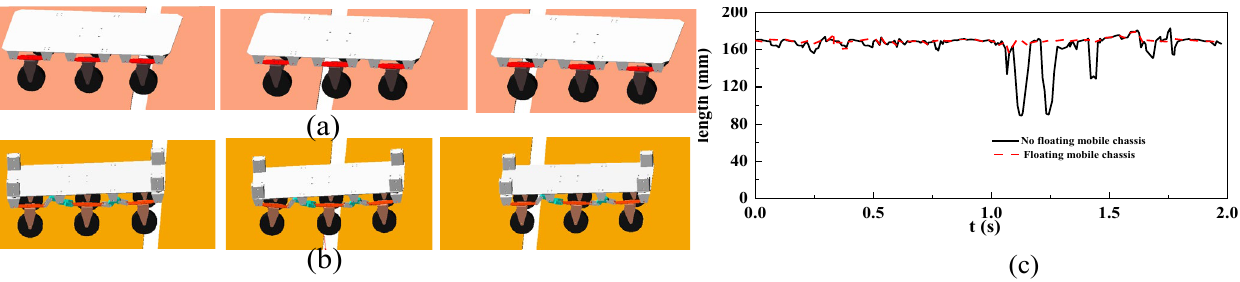
Figure 10. Motion simulation of boss crossing obstacles: ( a ) the obstacle-climbing process of no float- ing mobile chassis; ( b ) the obstacle climbing process of the floating mobile chassis; ( c ) simulation results–change curve of centroid height of two types of the plates.